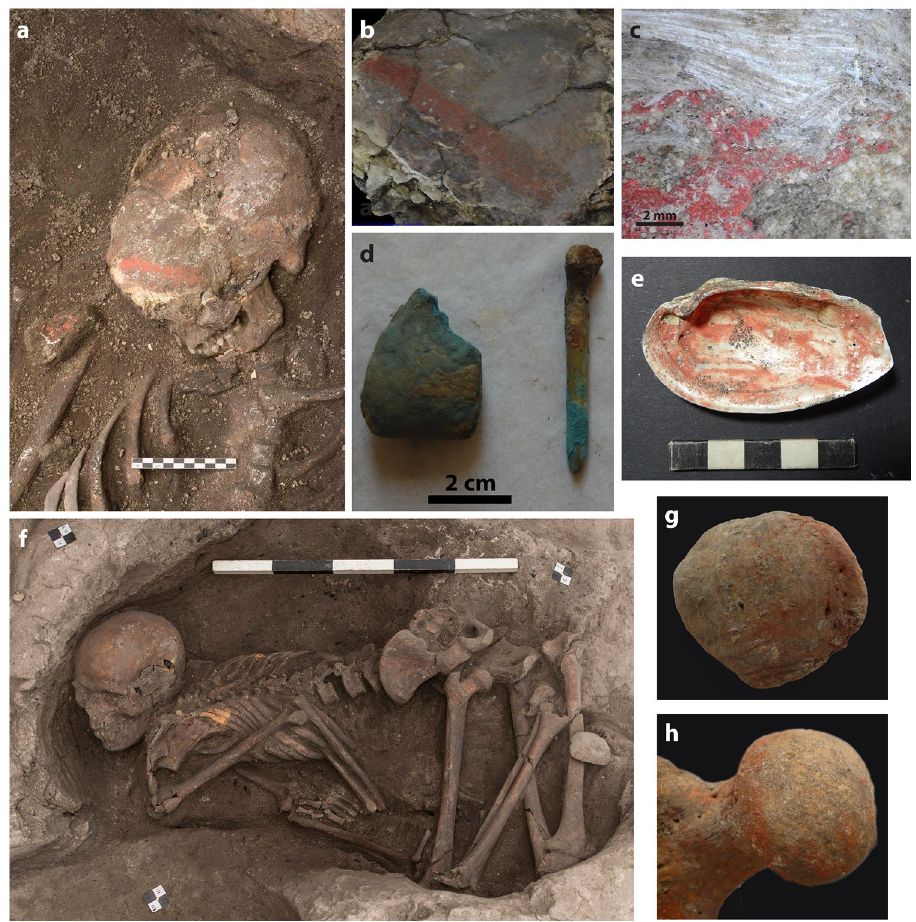
Figure 2. Examples of funerary pigment use at Çatalhöyük. ( a ) In situ photograph from skeleton 32818 with cinnabar stripe and a shell with cinnabar deposited at the right shoulder (Photograph by J. Quinlan); ( b ) Detail of the cinnabar stripe (Photograph by M. Milella); ( c ) Microscopic image of the frontal bone of skeleton 22196 showing a cinnabar layer with unstained phytoliths on top (Photograph by E. Schotsmans); ( d ) Bone ‘applicator’ with lump of blue pigment recovered with skeleton 16308 (Photograph by J. Quinlan); ( e ) Unio shell ‘palette’ with cinnabar (22194.X6) (Photograph by R. Veropoulidou); ( f ) Individual 21884 was buried on its right side with the skeletal elements on the uppermost and left side of the skeleton more intensely stained with red pigment (Photograph by J. Quinlan); ( g ) Right patella of skeleton 21884 was more stained on its medial side (Photograph by E. Schotsmans); ( h ) The partial discolouration of the left femoral head confirms that individual 21884 was flexed and fleshed when the ochre was applied, leaving the main part of the femoral head unstained (Photography by E. Schotsmans). Figure generated with Adobe illustrator 23.0.6 (http:// www. adobe. com/ fr/ produ cts/ illus trator.